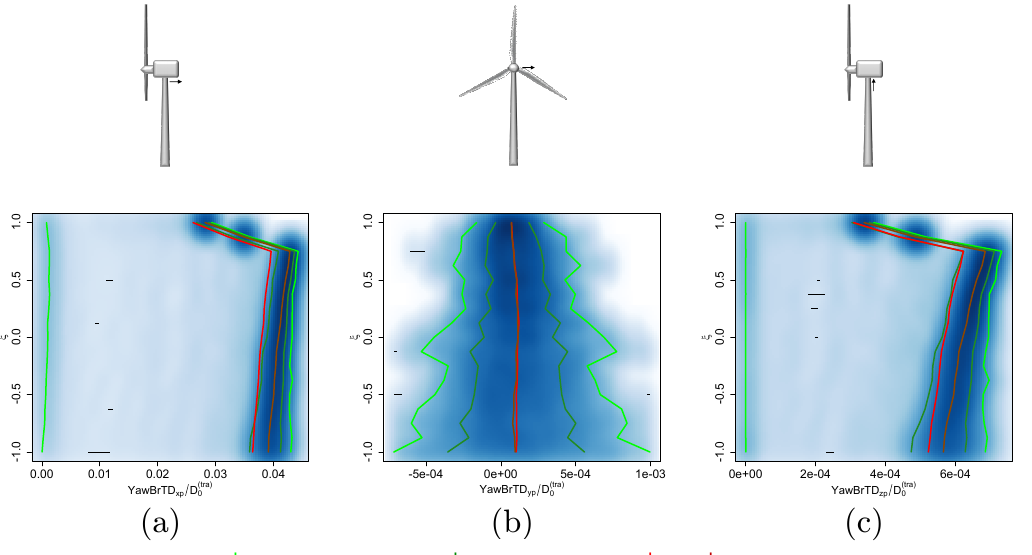
Figure 5. Variation with ξ of the PDFs of the tower top’s deflections. (a) Streamwise. (b) Spanwise. (c) Vertical. The parameter ξ is represented by the vertical axis, starting with an entirely positive shear at the bottom (where ξ = − 1) and ending with an entirely negative shear at the top (where ξ = 1). The horizontal axis represents values of the tower top’s deflections (YawBrTD) normalized by a reference ( D (tra) ). The background color is deeper where values are more concentrated. The red line and the dark red line connect the mean and the 0 median values, respectively. The green lines and the dark green lines delimit the zones encompassing 95 and 68% of the values,